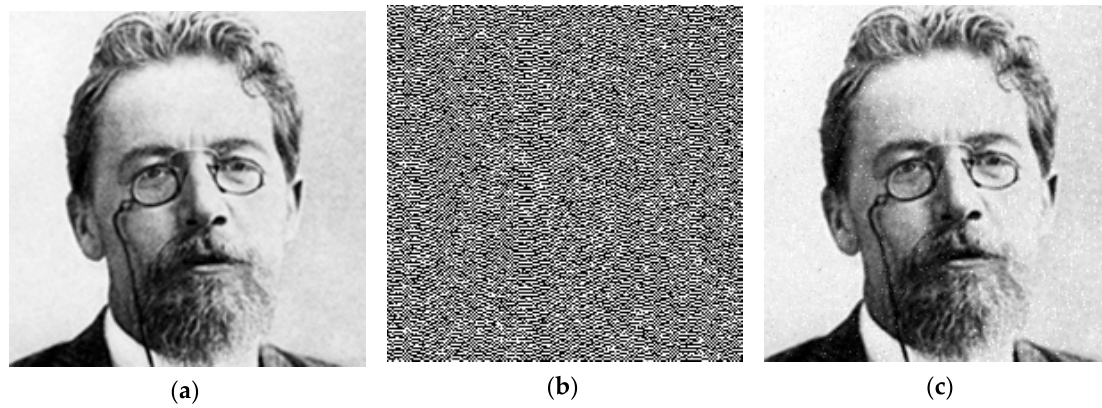
Figure 22. Test images: ( a ) Test black and white image with 256 gradations of the gray level at the system input; ( b ) Signal in the communication channel; ( c ) Restored image.